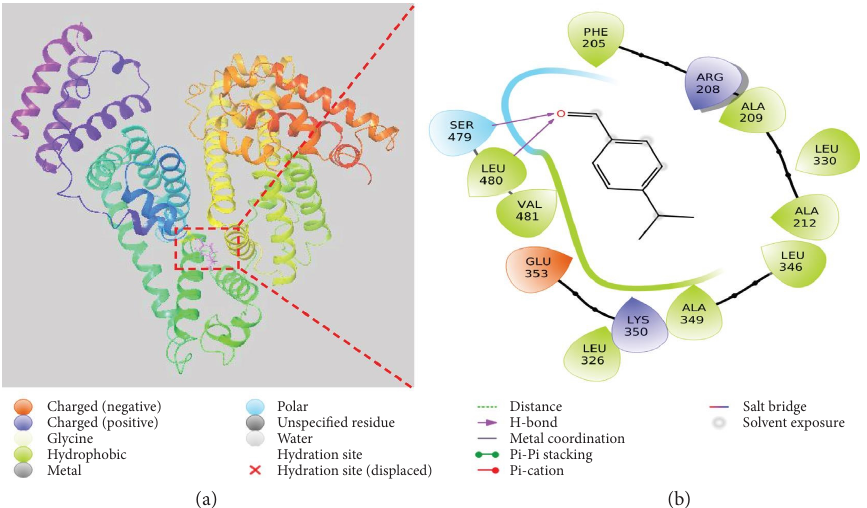
Figure 5: Molecular docking of cuminaldehyde with BSA. (a) Binding site of cuminaldehyde on BSA, and (b) BSA–cuminaldehyde molecular interaction.